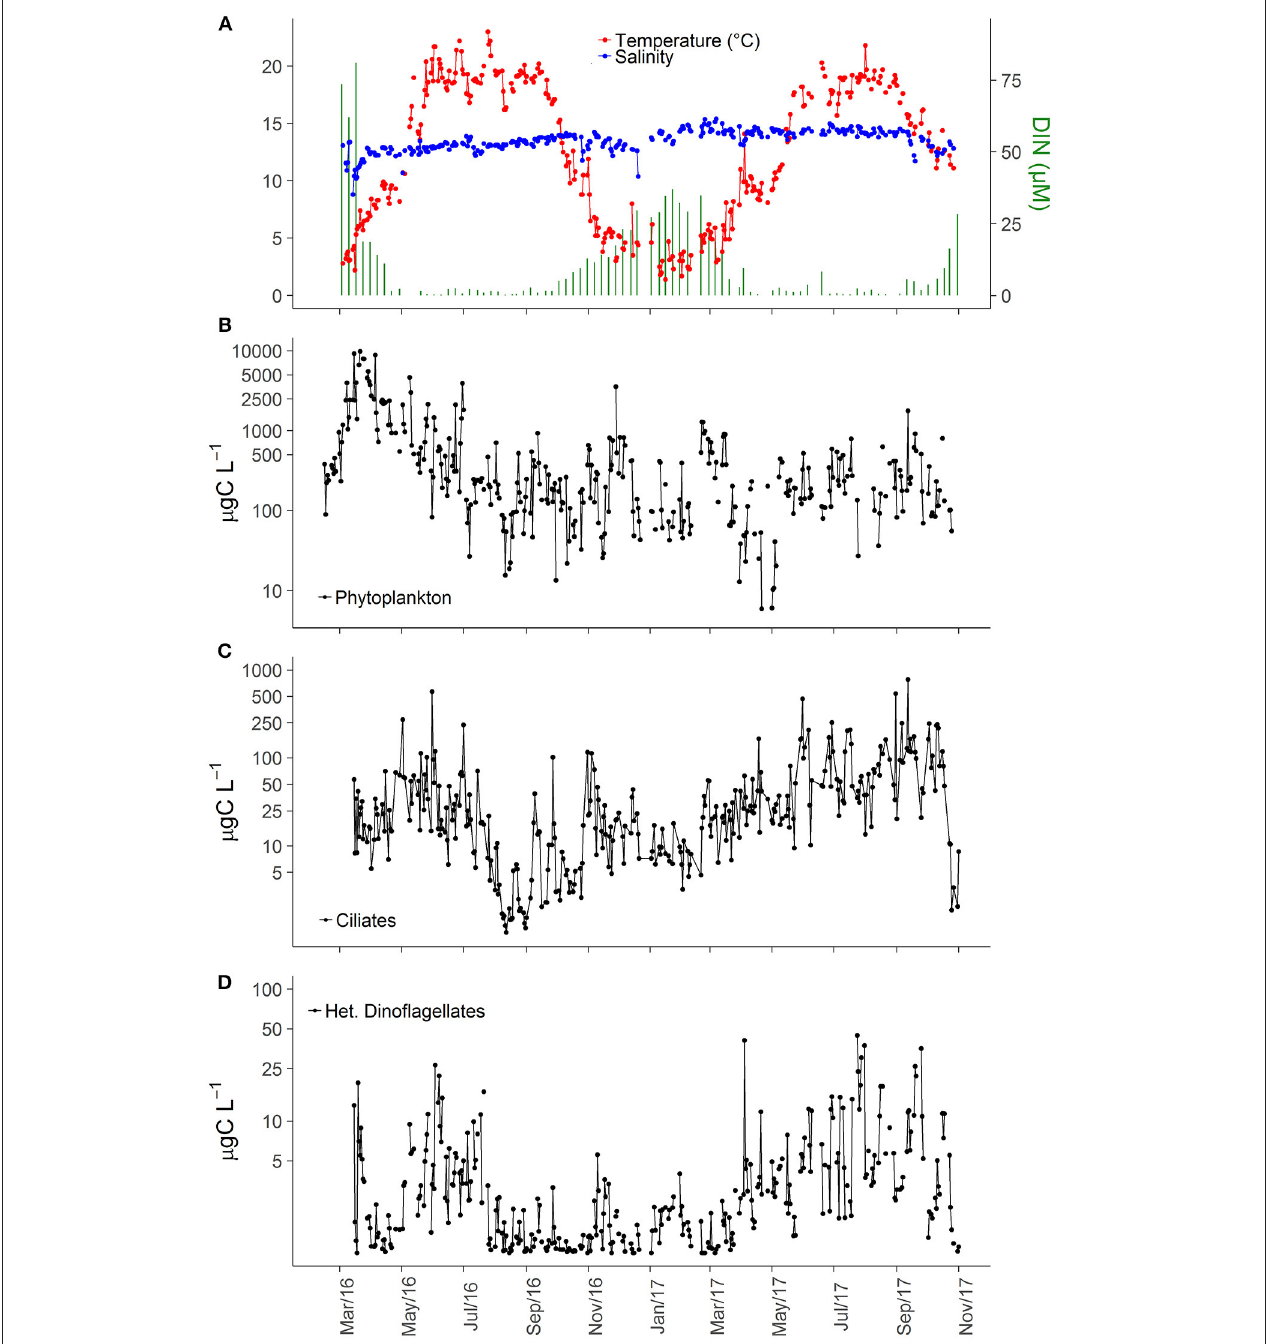
FIGURE 2 | Time series of abiotic variables (A) , carbon biomass of all phytoplankton cells (B) , all ciliate cells (C) , and all heterotrophic dinoflagellates cells (D) in inner Roskilde Fjord during the study period.